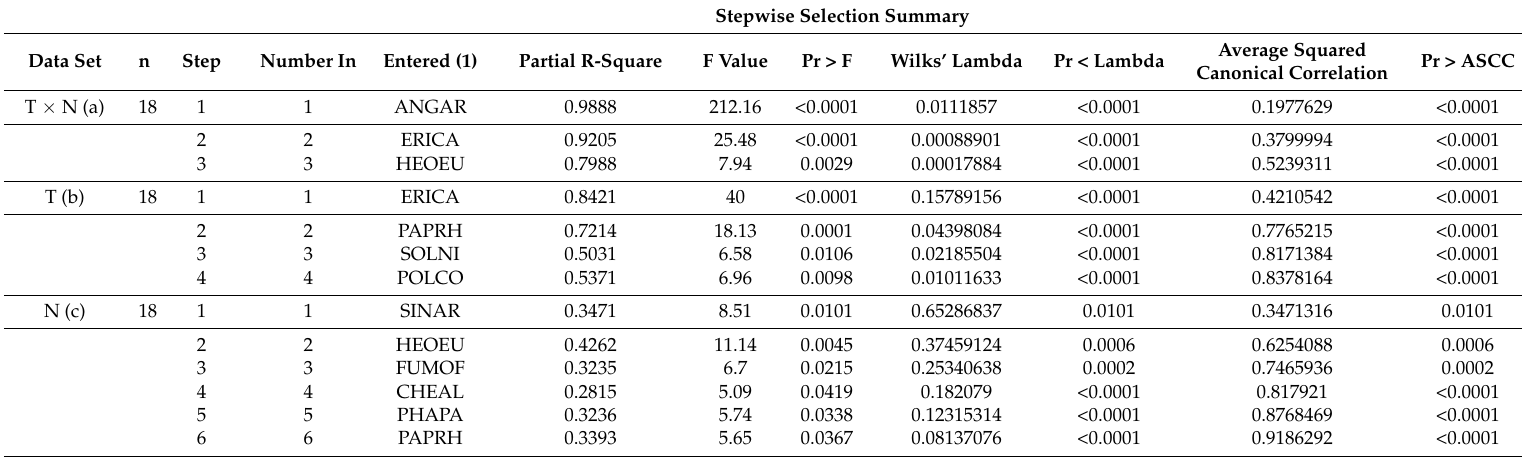
Table 3. Results of Stepwise Discriminant Analysis carried out on the weed species of the 0 to 0.20 m layer, considering both the different managements separately (Tillage (b) and Nitrogen (c)) and their interaction (Tillage × Nitrogen (a)).